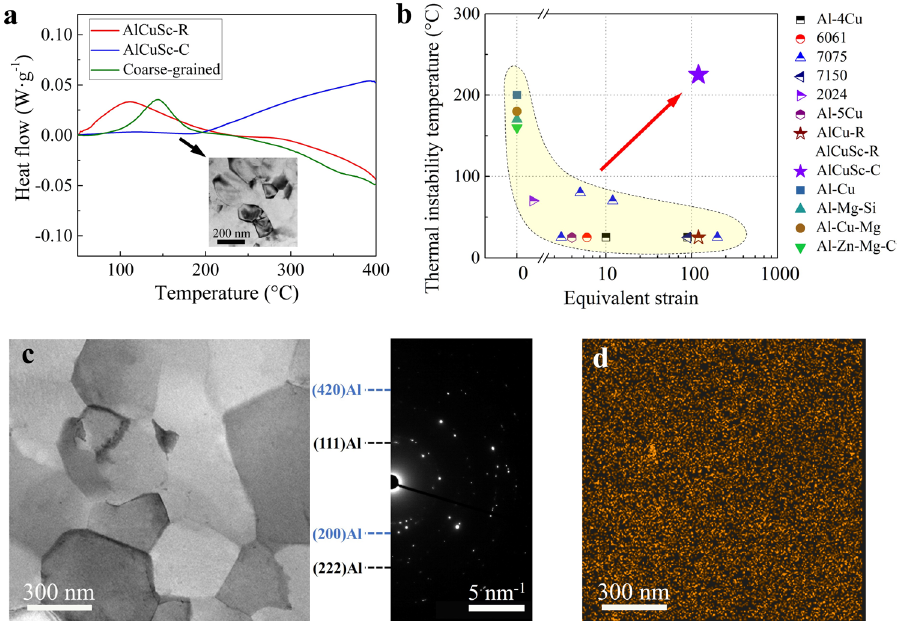
Fig. 3 High thermal stability of the AlCuSc-C alloy. a DSC heating curves of the AlCuSc-R, AlCuSc-C alloys, and coarse-grained Al-Cu-Sc alloy, inset is a typical bright- fi eld TEM image of AlCuSc-C aged at 175 °C for 50 h. b The minimum temperature for thermal instability of some typical cast Al alloys, including Al-Cu 44 , Al-Mg-Si 13 , Al-Cu-Mg 46 , Al-Zn-Mg-Cu 45 , and SPD-processed Al alloys, such as Al-4Cu 20 , 6061 40 , 7075 41 , 7150 42 , 2024 43 , and Al-5Cu 22 . c Typical bright- fi eld TEM image and corresponding selected area electron diffraction (SAED) pattern of the AlCuSc-C alloy aged at 225 °C for 50 h. d Corresponding elemental mapping of Cu in c